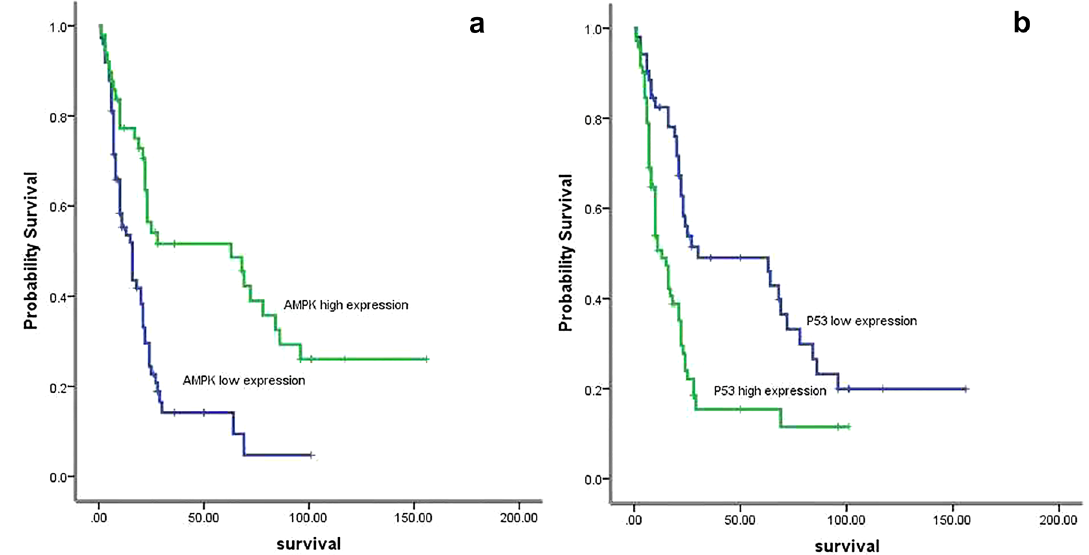
Figure 8. Expression of AMPK and p53 correlates with survival of NSCLC patients. ( a ) AMPK high expression had a longer survival than those with AMPK low expression. ( b ) P53 low expression had a longer survival compared with P53 high expression.